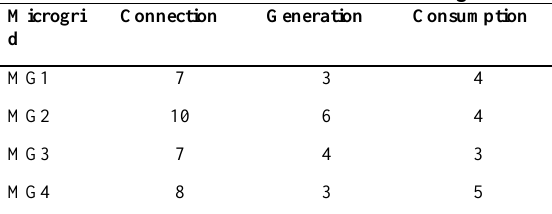
Figure 13. Reactive of Power Profile of Buses.